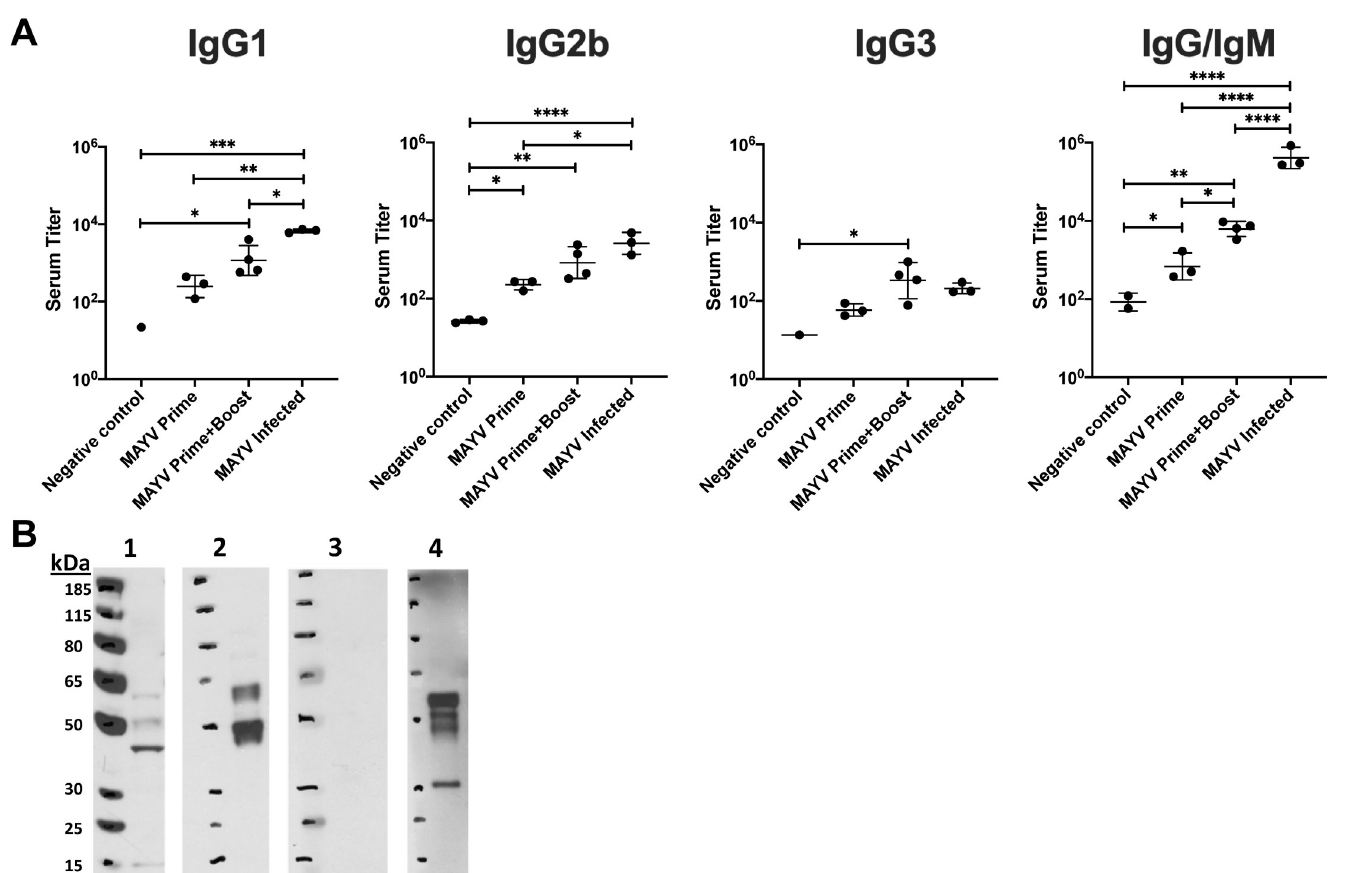
Fig 3. Characterization of Anti-MAYV Antibody Responses. (A) Isotype specific ELISAs were performed to characterize and measure the MAYV BeAr binding antibodies in sera from na ï ve, AdV-MAYV prime vaccinated, AdV-MAYV prime + boost vaccinated, and MAYV infected mice. Preparations of heat inactivated whole MAYV stocks were bound to high affinity 96-well plates. Serial dilutions of mouse sera were plated in order to calculate binding dilution titer. Binding antibodies were detected by secondary antibodies specific for mouse IgG1, IgG2a, and IgG3 as well as a pan IgG/IgM. Error bars represent SD representative of quadruplicate biological replicates. Statistical analysis was performed on log transformed data by a one-way ANOVA ( � P < 0.05, �� P < 0.005, ��� P = 0.0001, P < 0.0001). (B) Western blot analysis was used to determine antigen specificity of antibodies in serum from vaccinated mice. Protein lysates containing purified MAYV TrVl were separated by SDS-PAGE and transferred to immunoassay membranes for western blotting. Cross-reactive anti-CHIKV E1 (panel 1) and E2 (panel 2) monoclonal antibodies were used to identify MAYV envelope proteins. Serum derived from na ï ve mice (panel 3) and AdV-MAYV prime + boost vaccinated mice (panel 4) demonstrate the presence of envelope and capsid specific antibodies to MAYV TrVl following vaccination. The blots shown are representative images of 3 independent experiments.